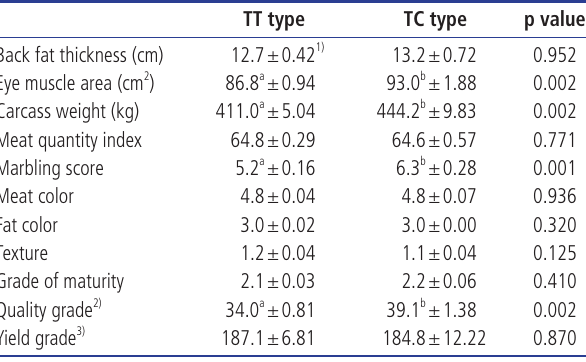
Table 4. Effect of ADH1C gene on carcass traits in Korean native steers during